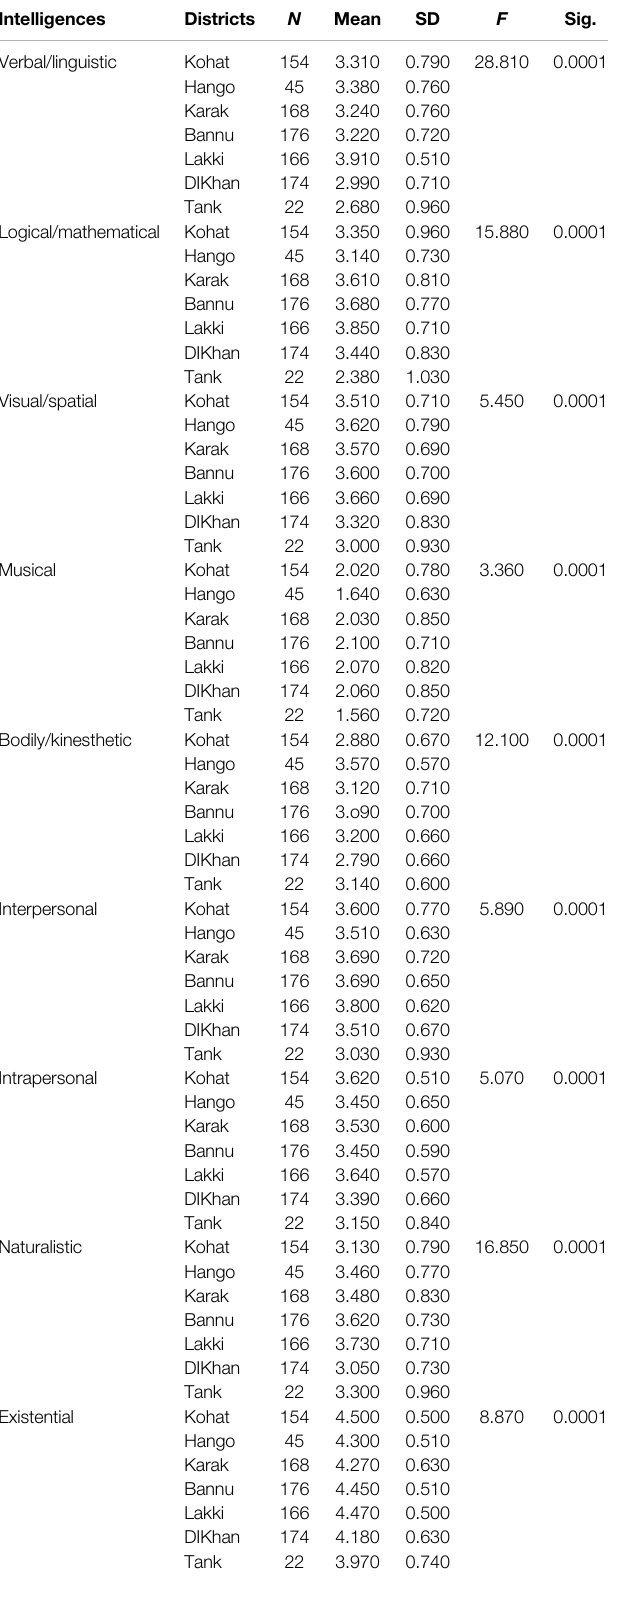
TABLE 2 | ANOVA analysis: Differences on students ’ self-estimation of multiple intelligence of southern districts ( n (cid:1) 905). Intelligences Districts